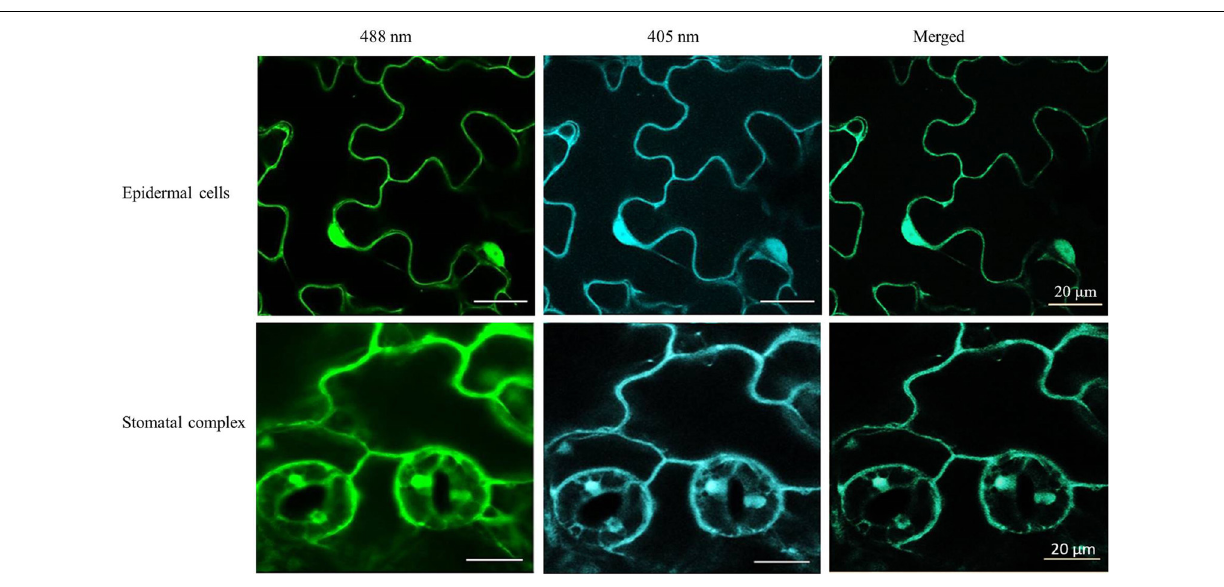
Frontiers in Plant Science |